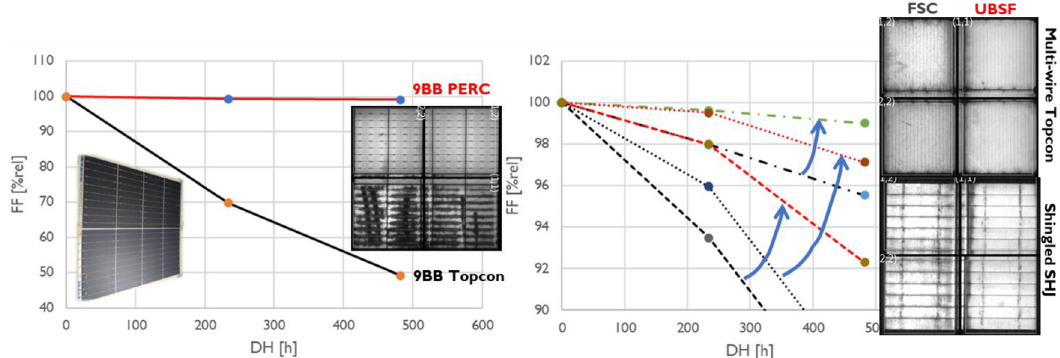
Fig. 15. Damp heat degradation of “ PERC ” compared to “ Topcon ” in an identical GFRB stack (left) and the improvement of implementing a frontsheet ( “ UBSF ” , red lines) with a lower WVTR than the standard one ( “ FSC ” ,